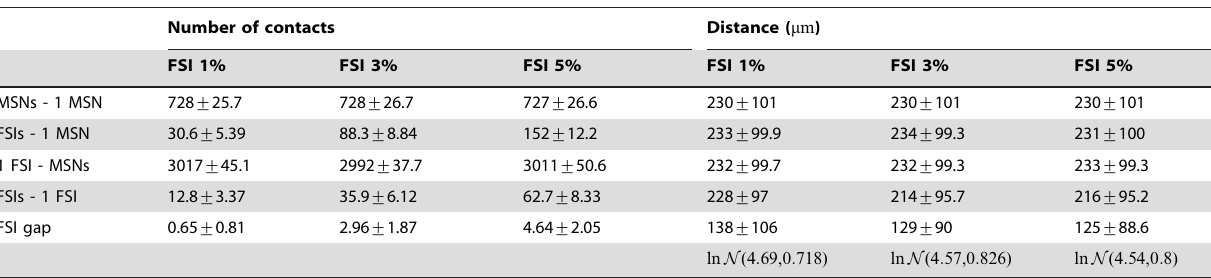
Table 5. Connection statistics of the model striatal